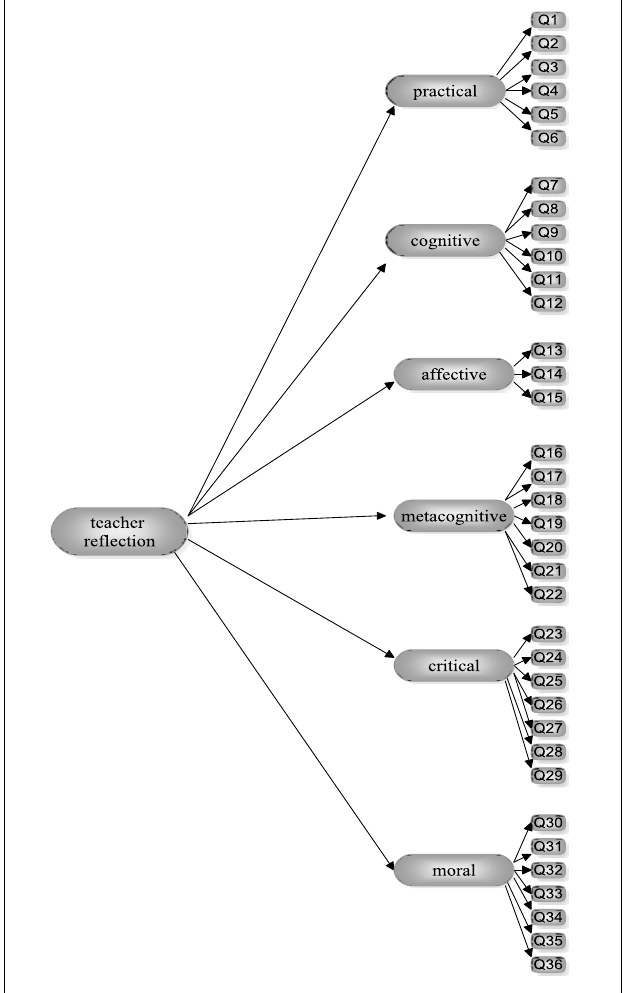
FIGURE 1 | Hypothesized model of teacher